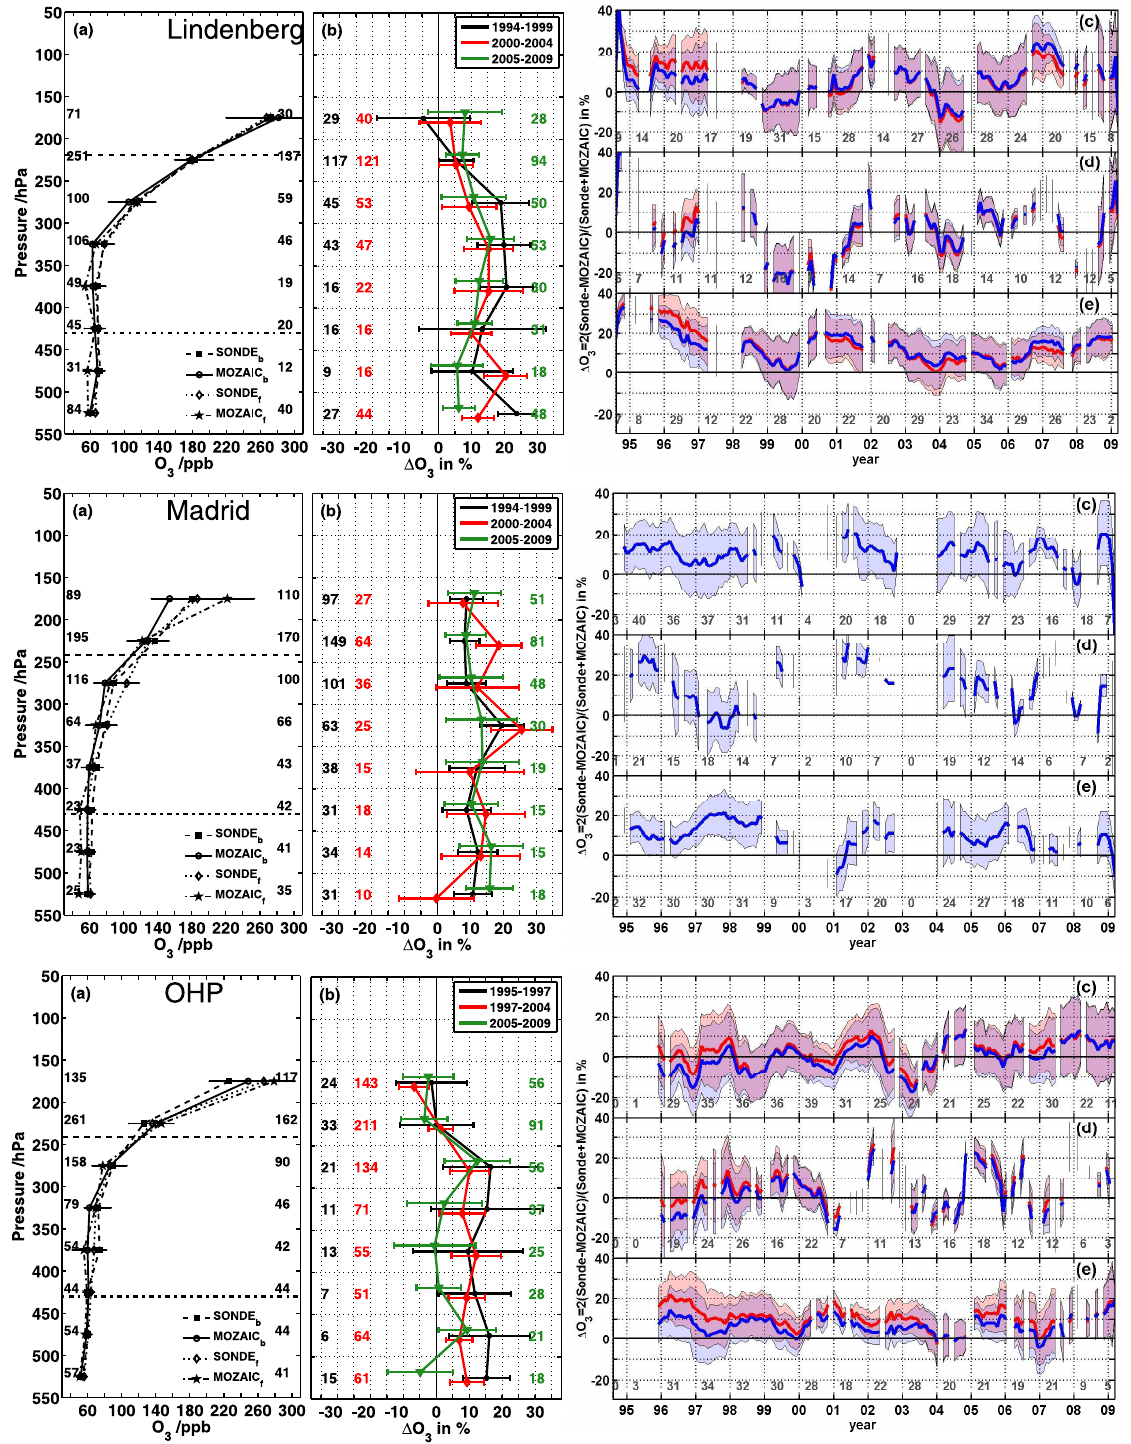
Fig. 7. Comparison of ozonesondes with MOZAIC measurements. As for Fig. 3, but for Lindenberg, Madrid, and the Observatory Haute Provence (OHP). ES sondes are flown at OHP since March 1997, while SP sondes were used before. Both are operated with a 1.0% electrolyte.